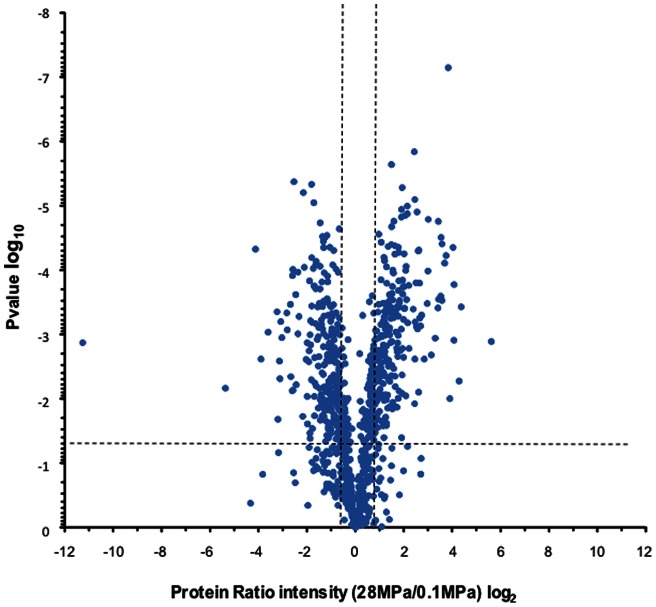
Volcano plot of the quantitative Photobacterium profundum proteomic data.Data statistical significance (p-value plotted in a log10 scale and calculated from a one-wayANOVA, see material and methods for details) is plotted in function of the protein ratio intensity (protein intensity at 28 MPa/protein intensity at 0.1 MPa) in a log2 scale. The horizontal dashed line shows where p-value  = 0.05 and the two vertical dashed lines separate proteins having an absolute fold-change of 1.5.